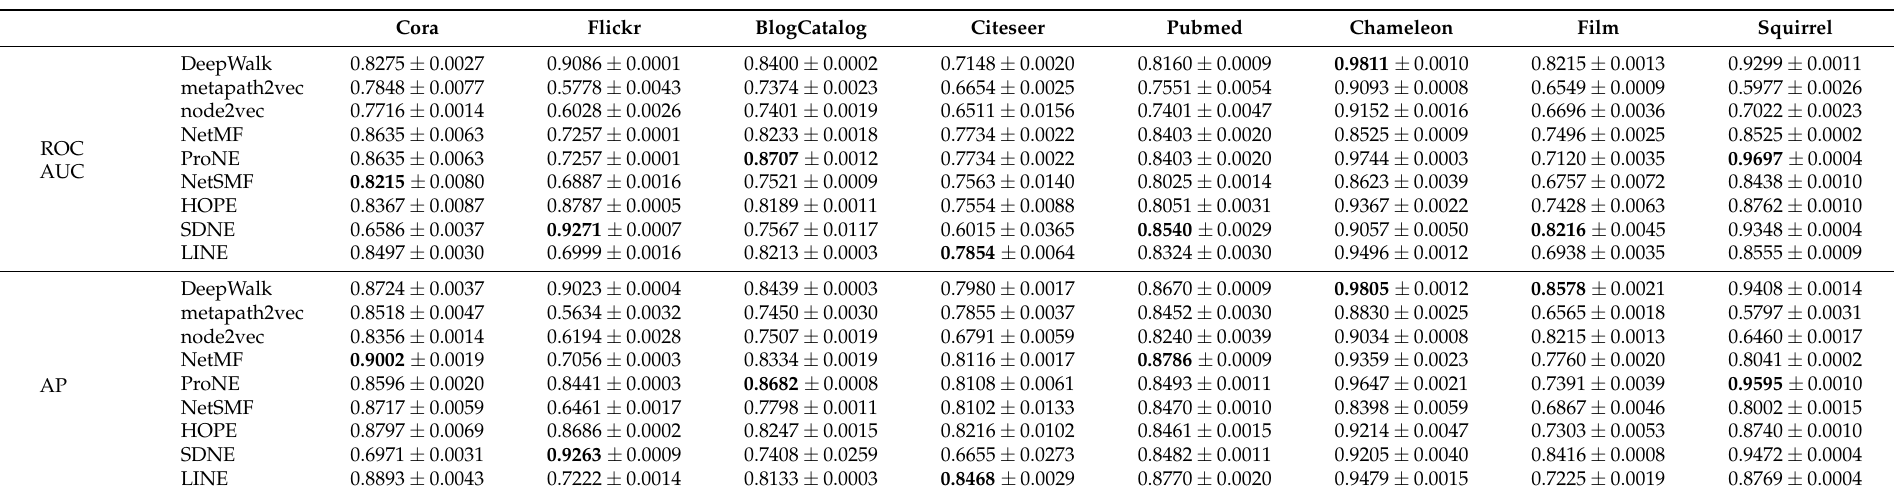
Table 4. Results in Task 2, i.e., link prediction fine-tuned in the first run, on pure networks, using random search to tune hyperparameters. Best results are shown in